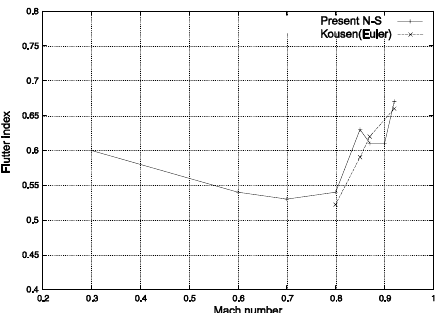
Fig. 4 Flutter boundary for test case I (NACA 64A006).